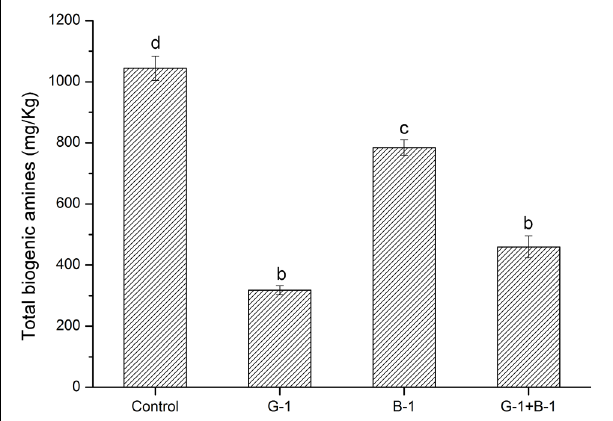
FIGURE 4 | BAs contents in fermented meat product model inoculated with different strains. Different letters (a, b, c, etc.) indicate significantly different means at P <